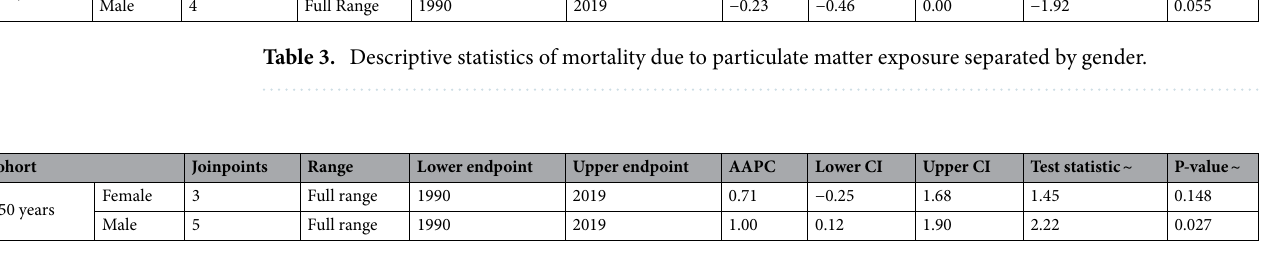
Table 4. Descriptive statistics of mortality due to ambient ozone exposure separated by gender.